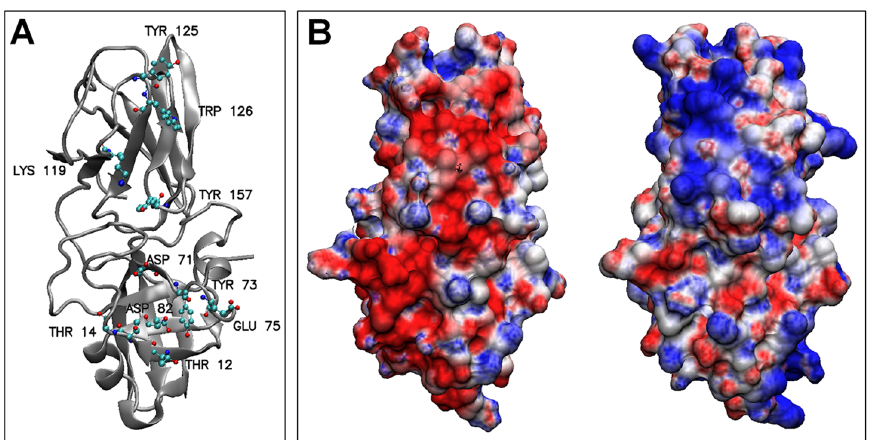
Figure 4. PcExl1 is an acidic protein with a similar structure to BsEXLX1. (a) Predicted carbohydrate binding surface of PcExl1. The backbone of the protein is depicted by a silver ribbon, and the sugar-binding residues are shown as labeled balls and sticks. (b) Electrostatic potential mapped at the protein surface, for the ‘‘back’’ of PcExl1 (left) and BsEXLX1 (right). Positive potential is shown in blue and negative potential in red, for a range of 2 5 to + 5kT/e. The proteins are rotated 180 degrees with respect to panel (a), with the carbohydrate binding domain D2 at the top, and the double-psi beta barrel D1 at the bottom.